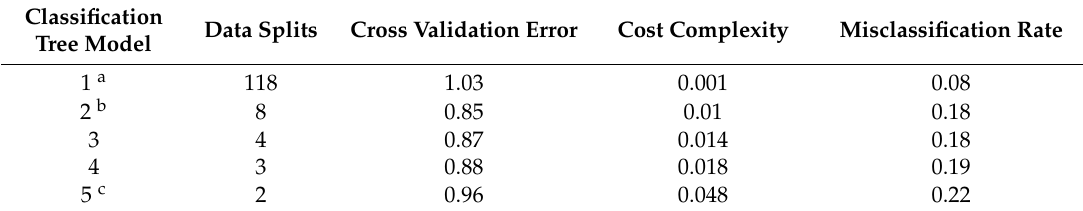
Table A1. Classification tree model results.